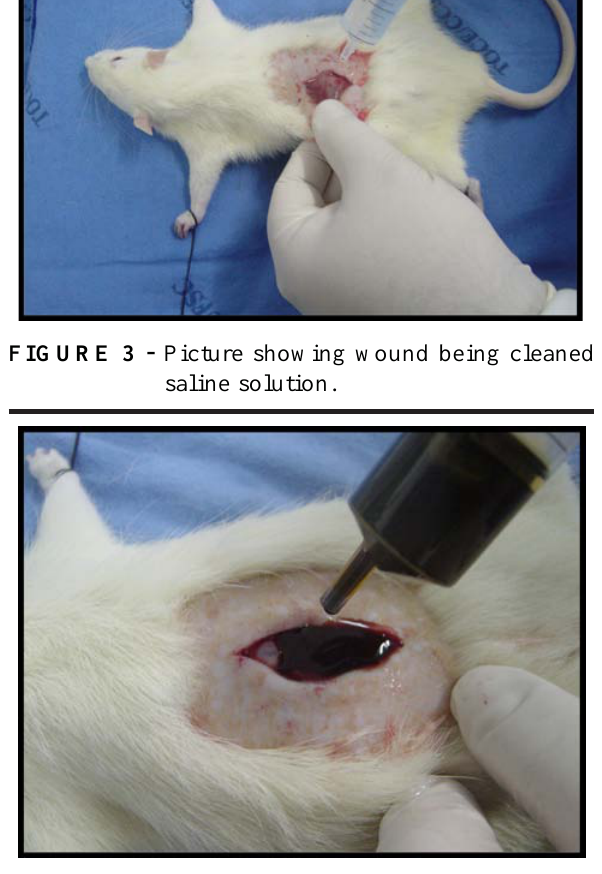
FIGURE 4 - Picture showing wound being cleaned with with